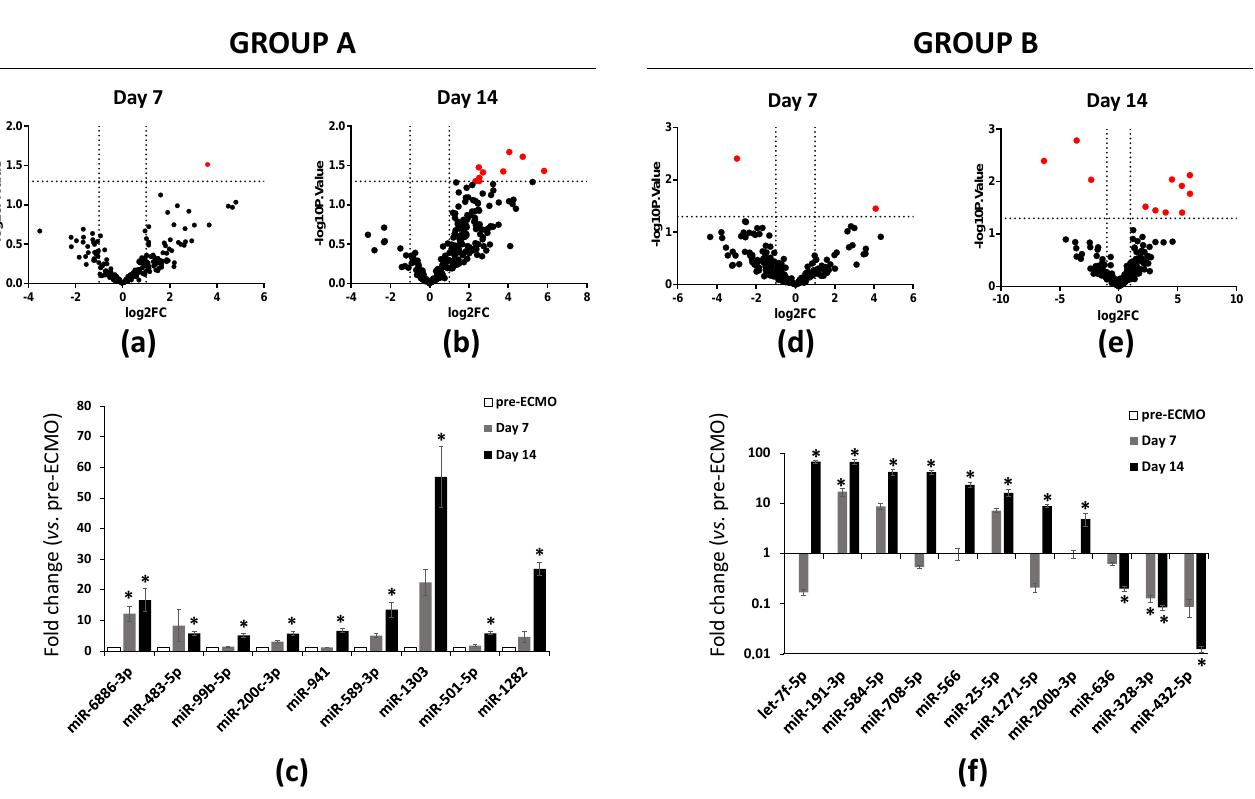
Figure 1. RT-PCR analysis of miRNAs in ARDS patients supported with ECMO for 14 days. ( a ) Volcano plot analysis ( p ≤ 0.05) plot analysis of RNAs in ARDS patients supported with ECMO group A patients after 7 and ( b ) 14 days of ECMO support. ( c ) Up-regulated miRNAs in group A patients after 7 and 14 days of ECMO support. ( d ) Volcano plot analysis ( p ≤ 0.05 and fold change ≥ 0) of deregulated miRNAs analyzed in group B patients after 7 and ( e ) 14 days of ECMO support. ( f ) Up- and down-regulated miRNAs in group B patients after 7 and 14 days of ECMO support. miRNA levels were normalized to those of U6. Data are means ± SD. (Comparisons made by Student’s t -test). * p < 0.05 vs. pre-ECMO (patients before cannulation).